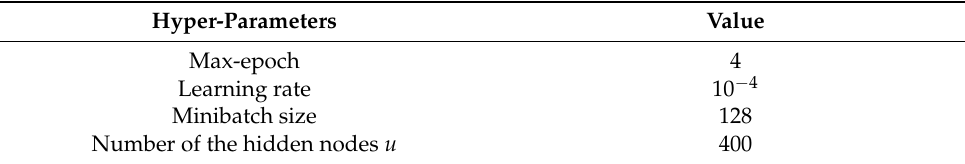
Table 3. The hyper-parameters of the ROENet.